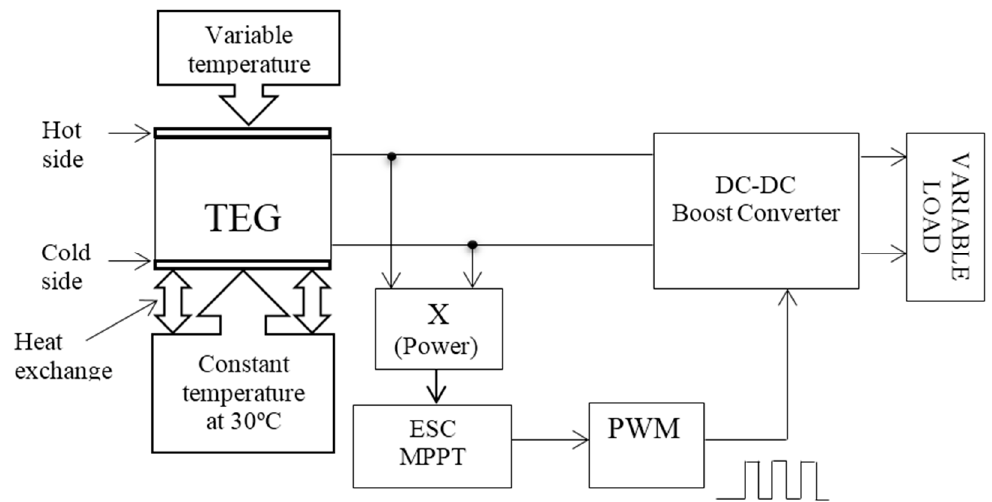
Figure 5. Block diagram of TEG/dc-dc converter system with ESC MPPT.